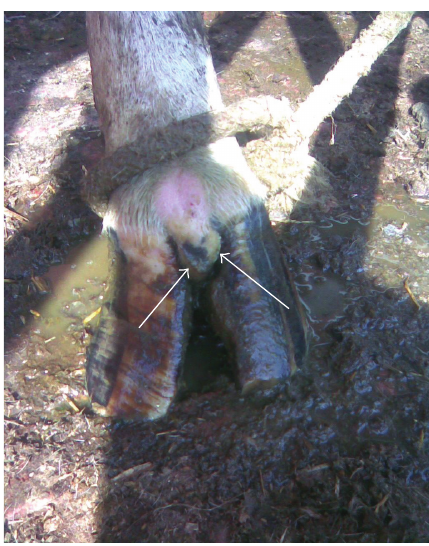
Figure 10: Interdigital